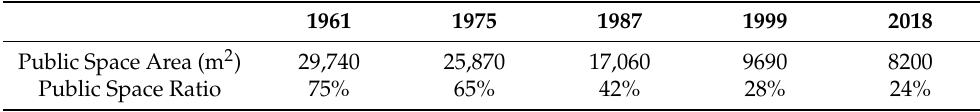
Table 4. Basic spatial information of AMS